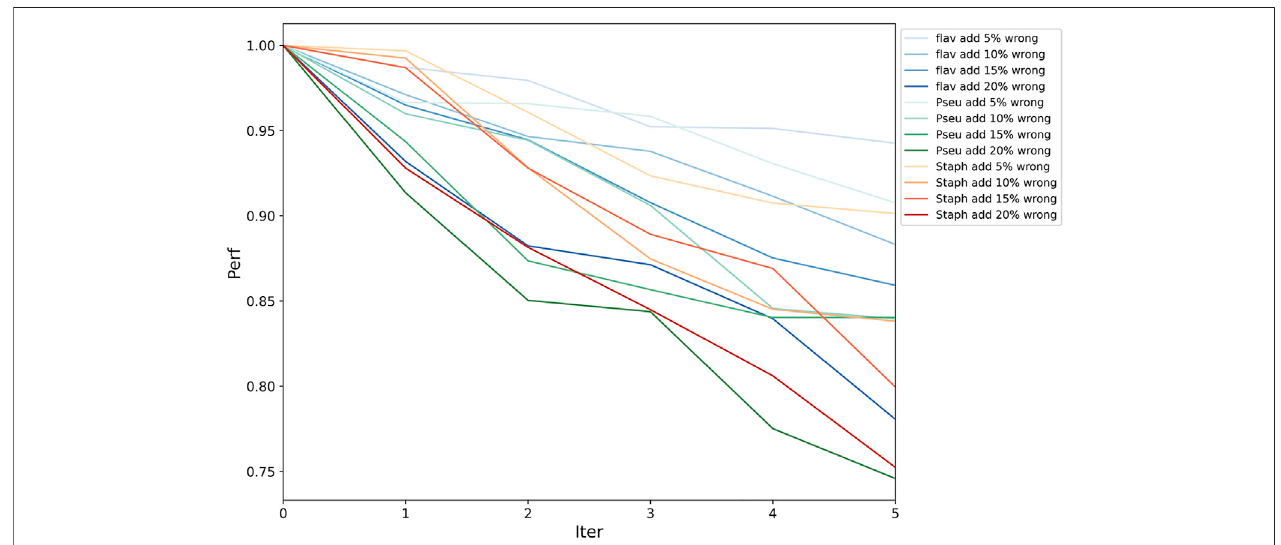
FIGURE 4 | Framework fault tolerance evaluation. On the three datasets, the performance was tested with the accumulation of 5 – 20% incorrectly labeled data in each epoch; the horizontal axis is the number of iteration, and the vertical axis is the performance indicator (current PRA/original PRA). This result shows that PPA-GCN has strong fault